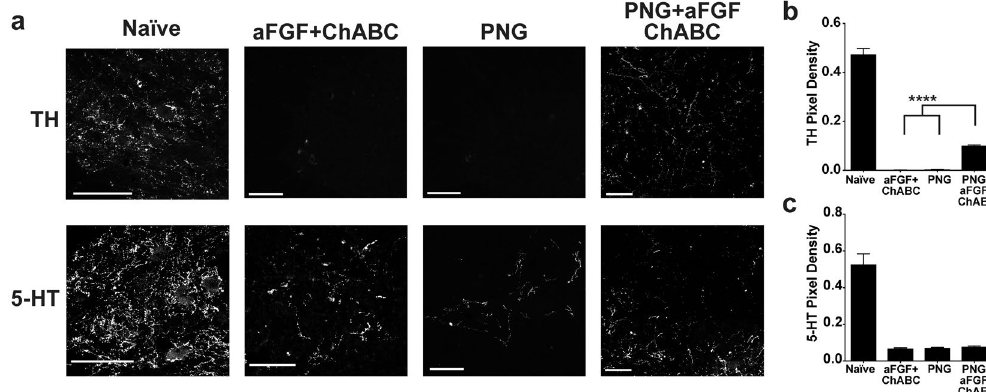
Figure 6. PNG + aFGF + ChABC increases lumbar TH + axons around the anterior horn. ( a ) Representative confocal images of TH + (top row) or 5-HT + (bottom row) stained transverse sections in the ventral grey horn of the lumbar spinal cord 40 weeks post-injury. Scale bar, 100 µ m. ( b , c ) Quantification of the density of TH + ( b ) and 5-HT + ( c ) immunoreactivity in the ventral grey horn of the lumbar spinal cord. n = 6 per group except naive n = 4. **** p < 0.0001. One-way ANOVA, Fisher’s Least Significant Difference post-hoc test. Data represent mean ±